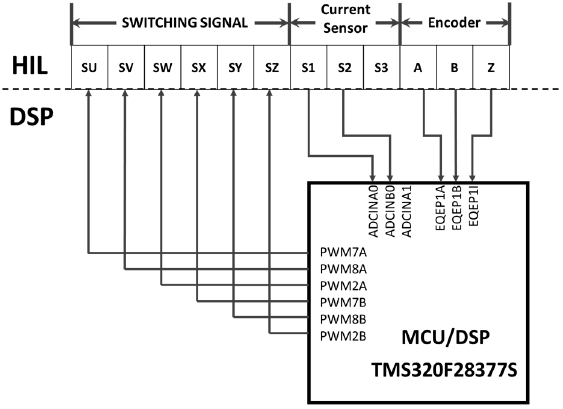
Figure 22. Connection of HIL and digital signal processor (DSP).